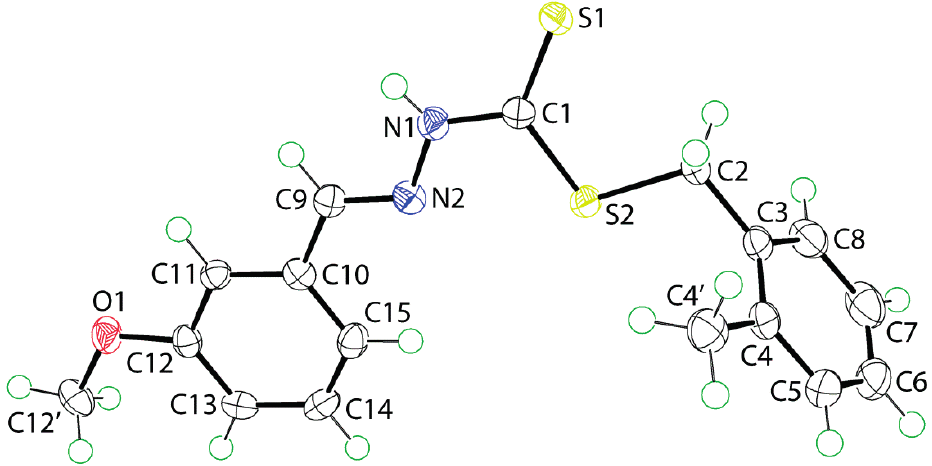
Figure 2. The molecular structure of 2 showing the atom-labeling scheme and 70% displacement ellipsoids.